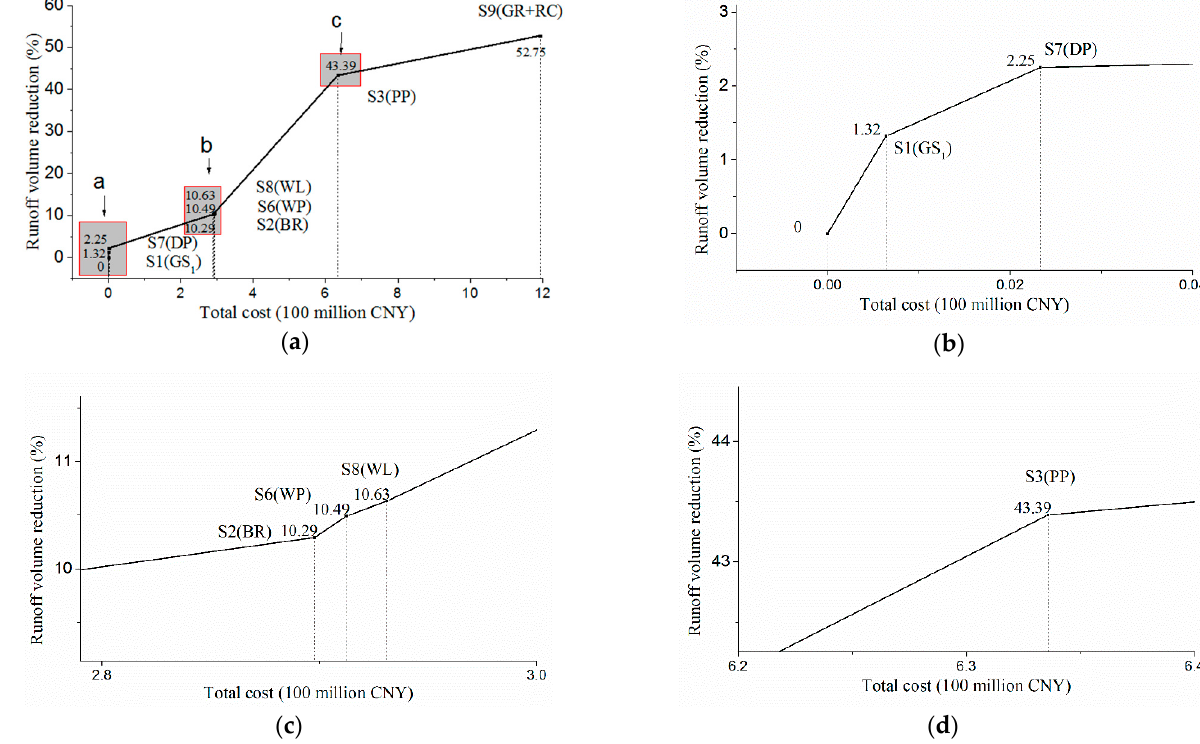
Figure 5. Relationship between total cost and runoff volume reduction with green roofs (GR) and rain cisterns (RC) implemented in series. ( b–d) were partial magnifications of ( a ).